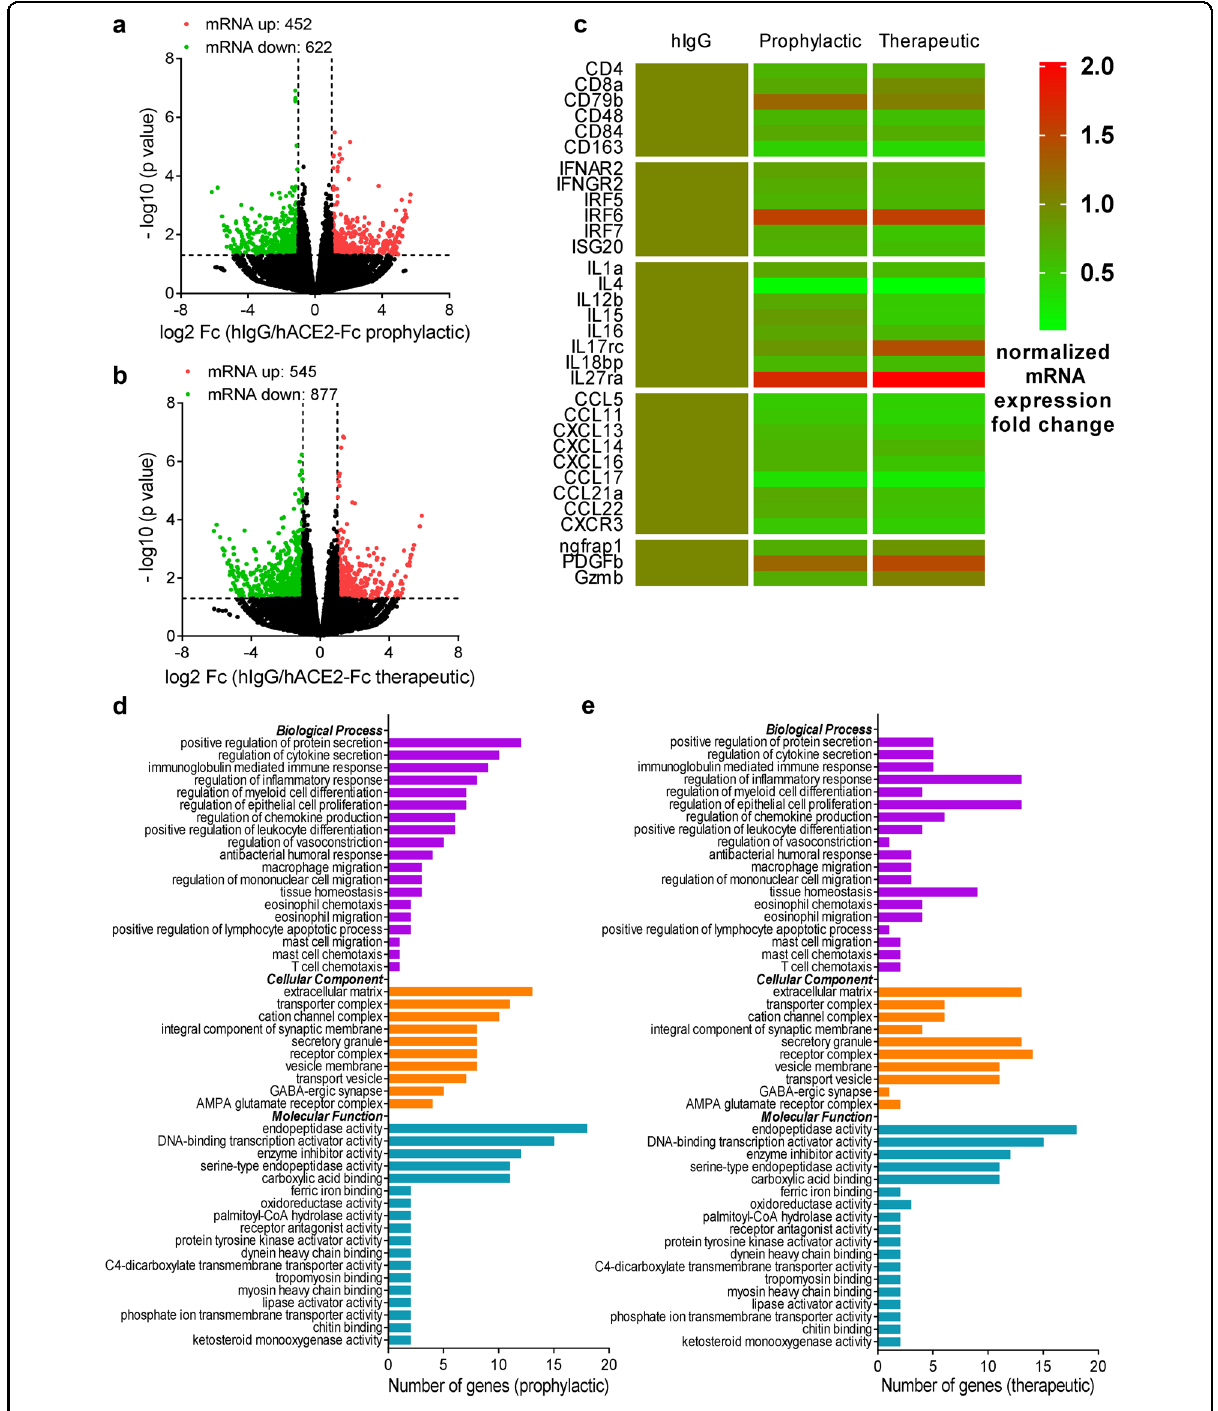
Fig. 5 Pulmonary gene expression changes in response to SARS-CoV-2 infection and hACE2-Fc administration. a, b Volcano plot showing differential mRNA expression in the lungs of hACE2-Fc prophylactic and therapeutic administrated mice, as compared to hIgG administrated mice. The upregulated and downregulated genes are marked by red and green colors, respectively. c Representative normalized mRNA expression fold changes among prophylactic, therapeutic and hIgG control groups were shown. d, e The KEGG annotation results of genes with different expression levels in hACE2-Fc prophylactic and therapeutic administrated mice compared to hIgG administrated mice. The functional categories including biological processes, cellular component, and molecular function were shown with different